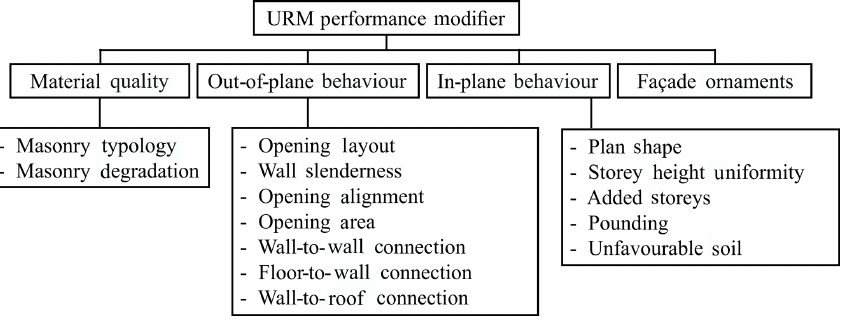
Figure 4. Performance modifier scheme. Table 4. Secondary parameters of RC buildings: definition, alternatives, scores and